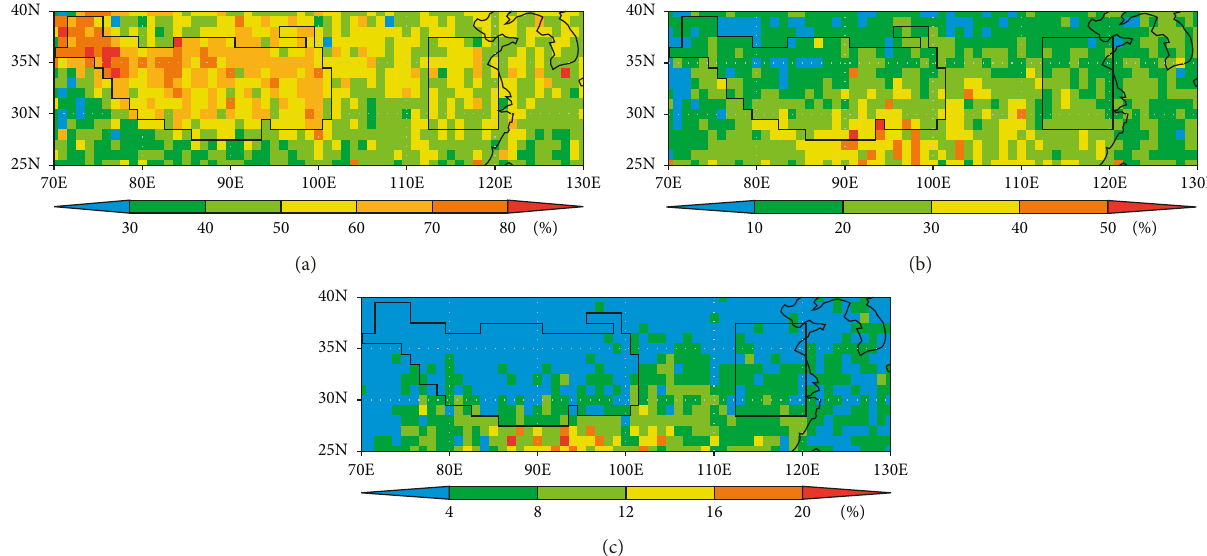
Figure 8: Occurrence distributions of (a) single-layered clouds, (b) two-layered clouds, and (c) three-layered clouds.